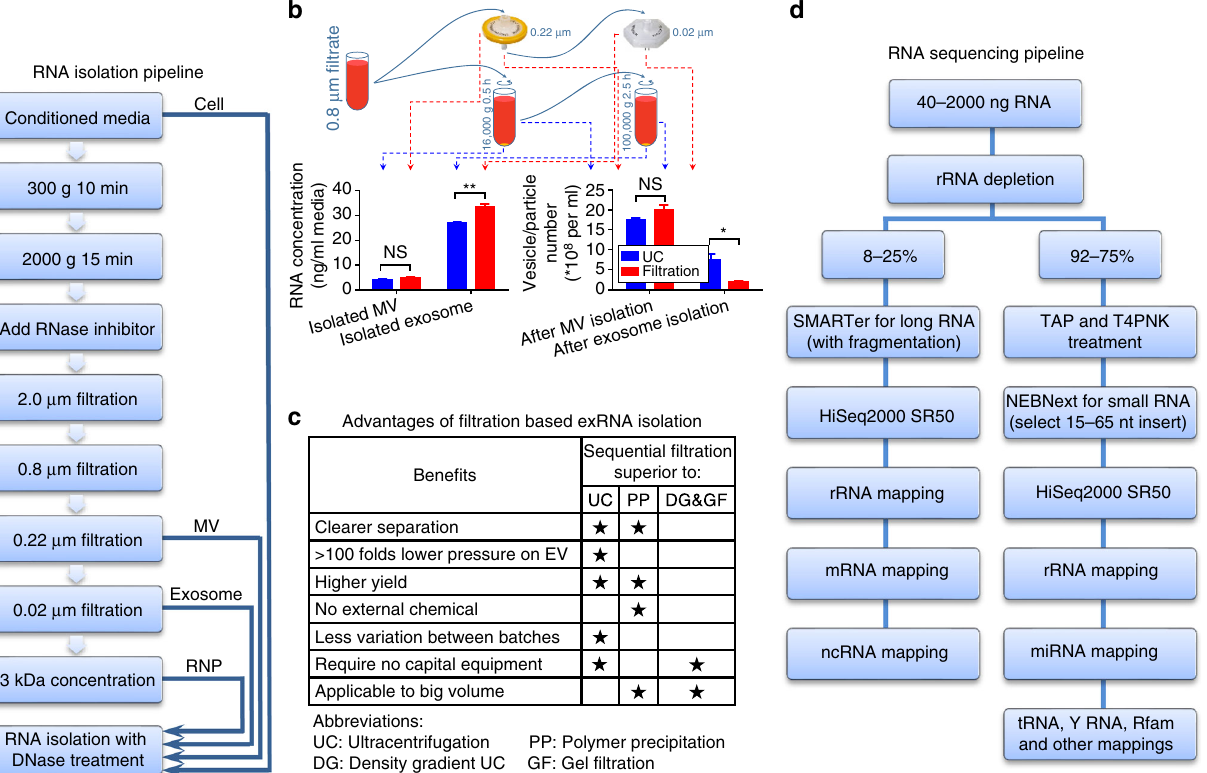
Fig. 1 Flowchart of the exRNA fractionation and sequencing. a The pipeline of the fi ltration-based exRNA isolation. Following removal of cells and cellular debris by low speed centrifugation, the supernatants were fi ltered through a sequence of reduced pore sizes (2.0, 0.8, 0.22, and 0.02 μ m) to separate the extracellular fractions, and a fi nal concentrator with the cutoff of 3 kDa was applied to collect the remaining small particles. b The aliquots of conditioned media after 0.8 μ m fi ltration were used for MV and exosome isolation, either by ultracentrifugation (UC) or fi ltration, and the RNA yield of these fractions compared. The number of remaining vesicles/particles was compared in UC supernatant and fi lter fl ow-through. N = 4 aliquots of conditioned media. All bars represent mean ± SEM. c Comparison between the fi ltration-based exRNA isolation and other common exRNA isolation methods. The stars mark superior characteristics of sequential fi ltration over other methods. d The optimized pipeline for the broad coverage, minimally biased RNA-sequencing. RNA of 15 – 65 nt was selected for the small RNA libraries, to reduce the overwhelming levels of tRNAs. NS, not signi fi cant; * p < 0.05; ** p < 0.01; t